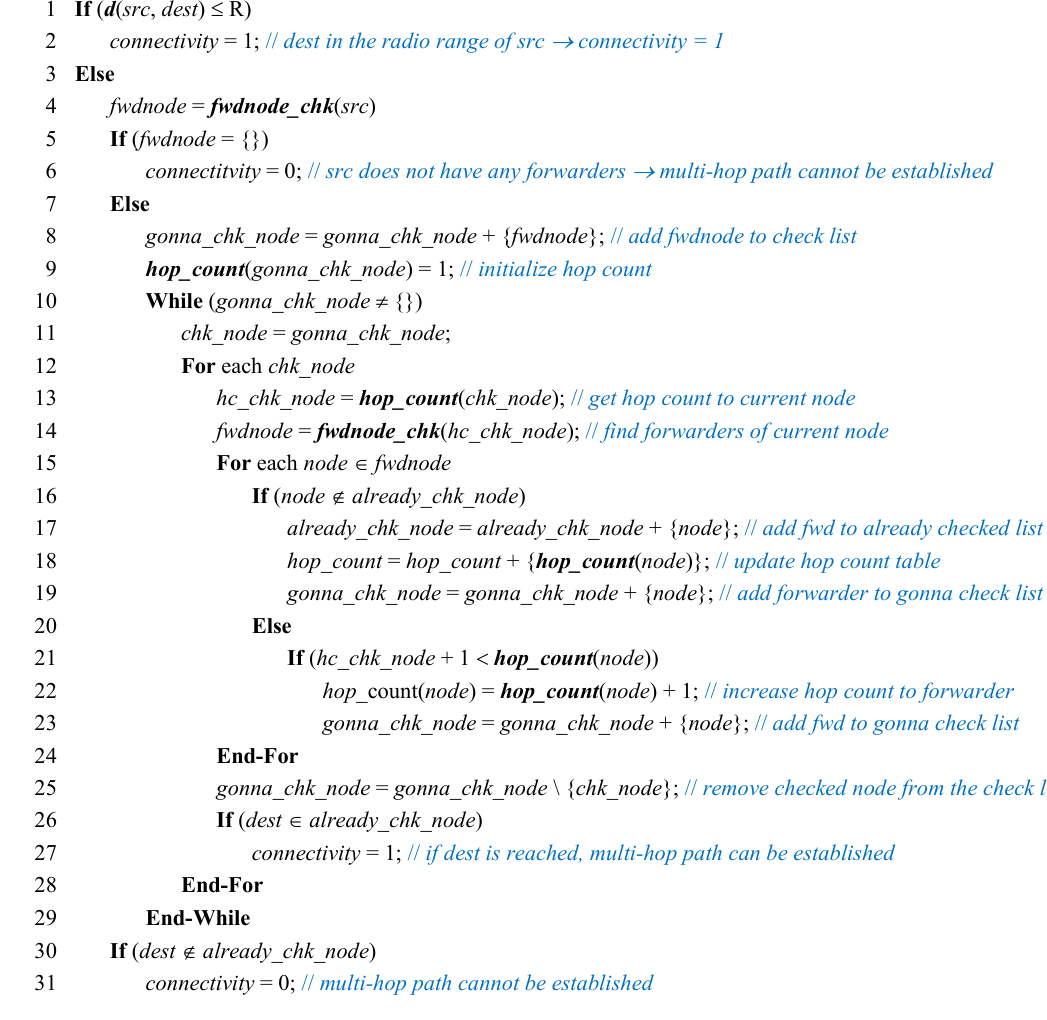
Figure 4. The pseudocode of our proposed algorithm to analyze the connectivity of multi-hop path between two arbitrary nodes in AHNs with given random wireless node